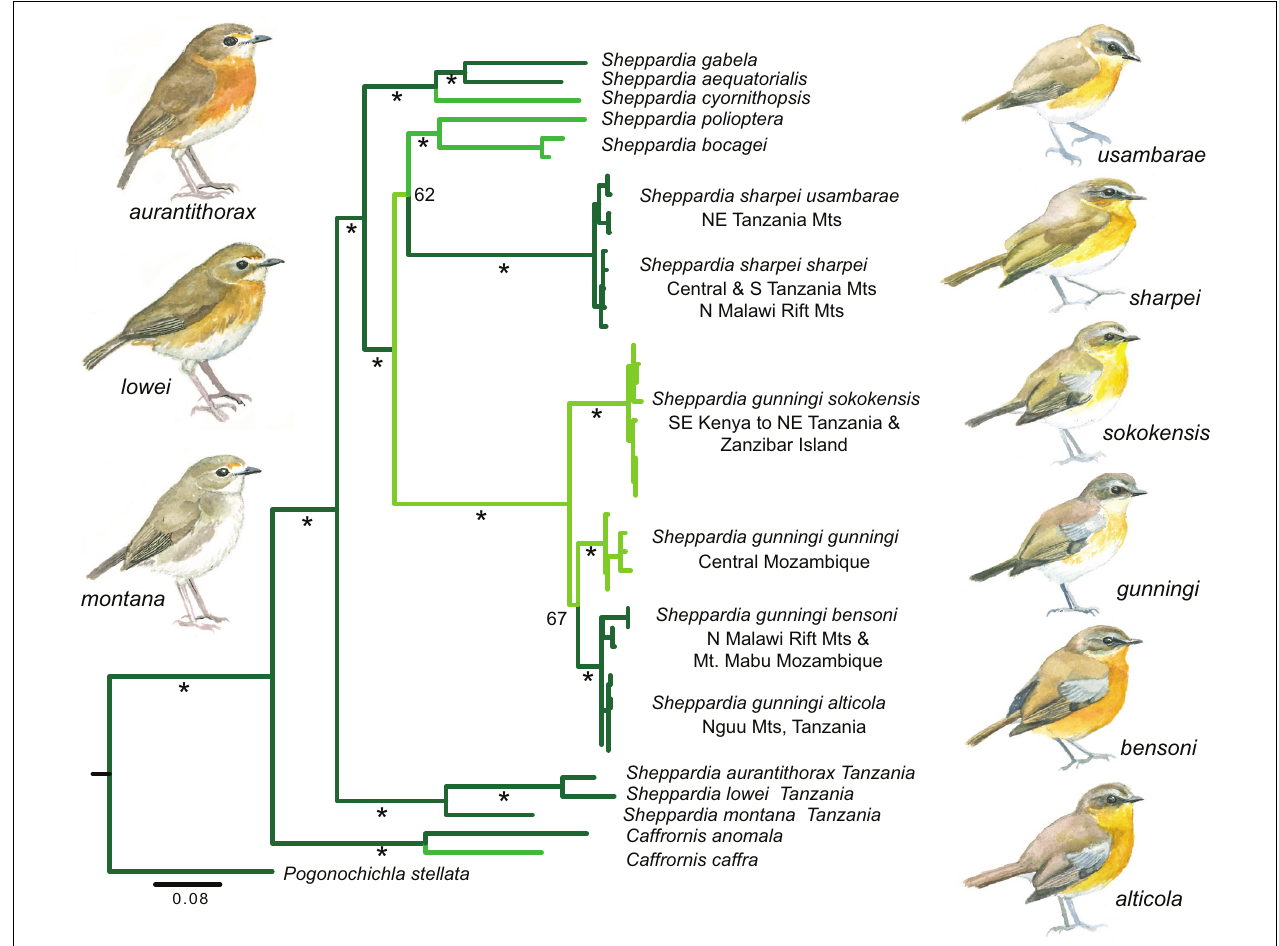
FIGURE 4 | Mitochondrial DNA (ATP6, ND2) phylogeny of Sheppardia akalats of Africa derived from a partitioned maximum likelihood analysis. Dark green branches are indicative of lineages that occupy montane forest, light green is indicative of lowland forest, and the intermediate green color is indicative of lineages that occupy a broad elevation range extending into both lowland and montane forest. * > 75% bootstrap